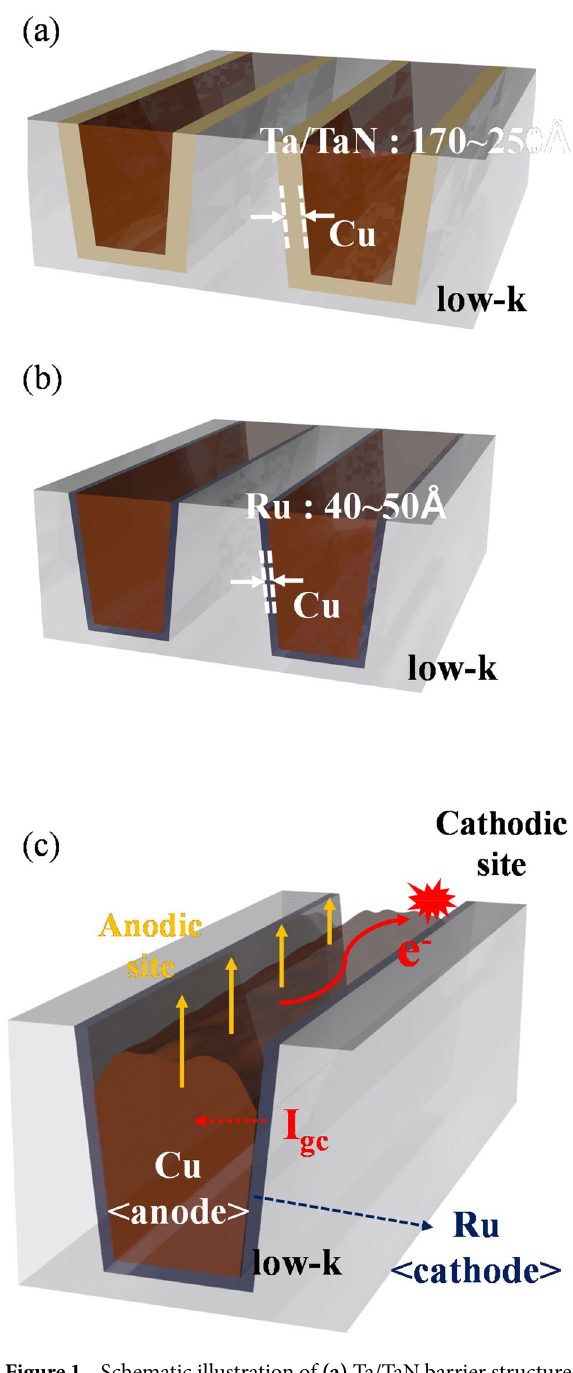
Figure 1. Schematic illustration of (a) Ta/TaN barrier structure, (b) Ru barrier structure, and (c) galvanic corrosion in a Cu/Ru bimetallic system; for Cu interconnect in back-end-of-the-line (BEOL)